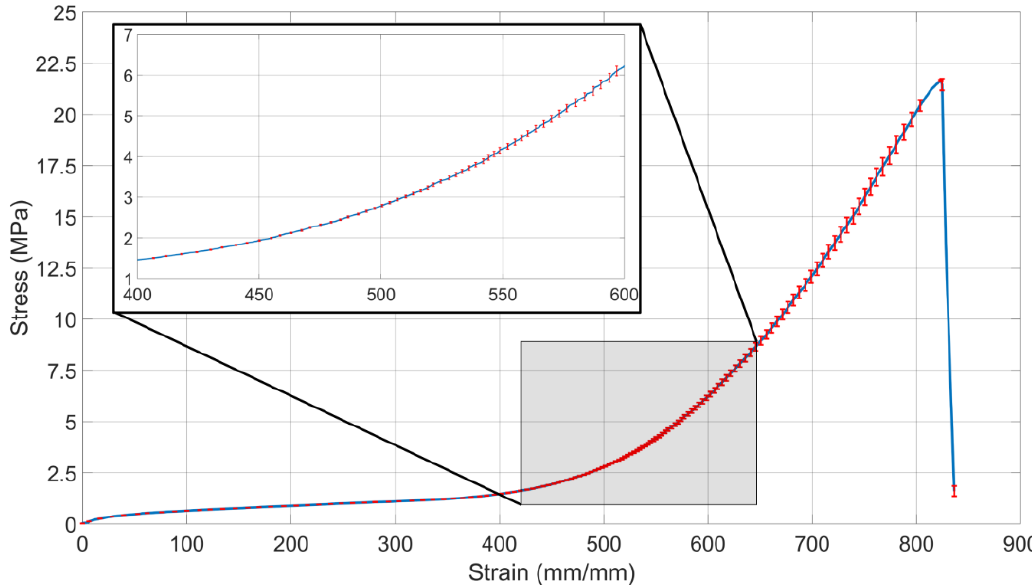
Figure 6. Stress-strain curve of the latex rubber. The blue line indicates the average of three tests and the error bars represent the standard error. The shaded area is magnified to show 400 mm/mm to 600 mm/mm strain range clearly.